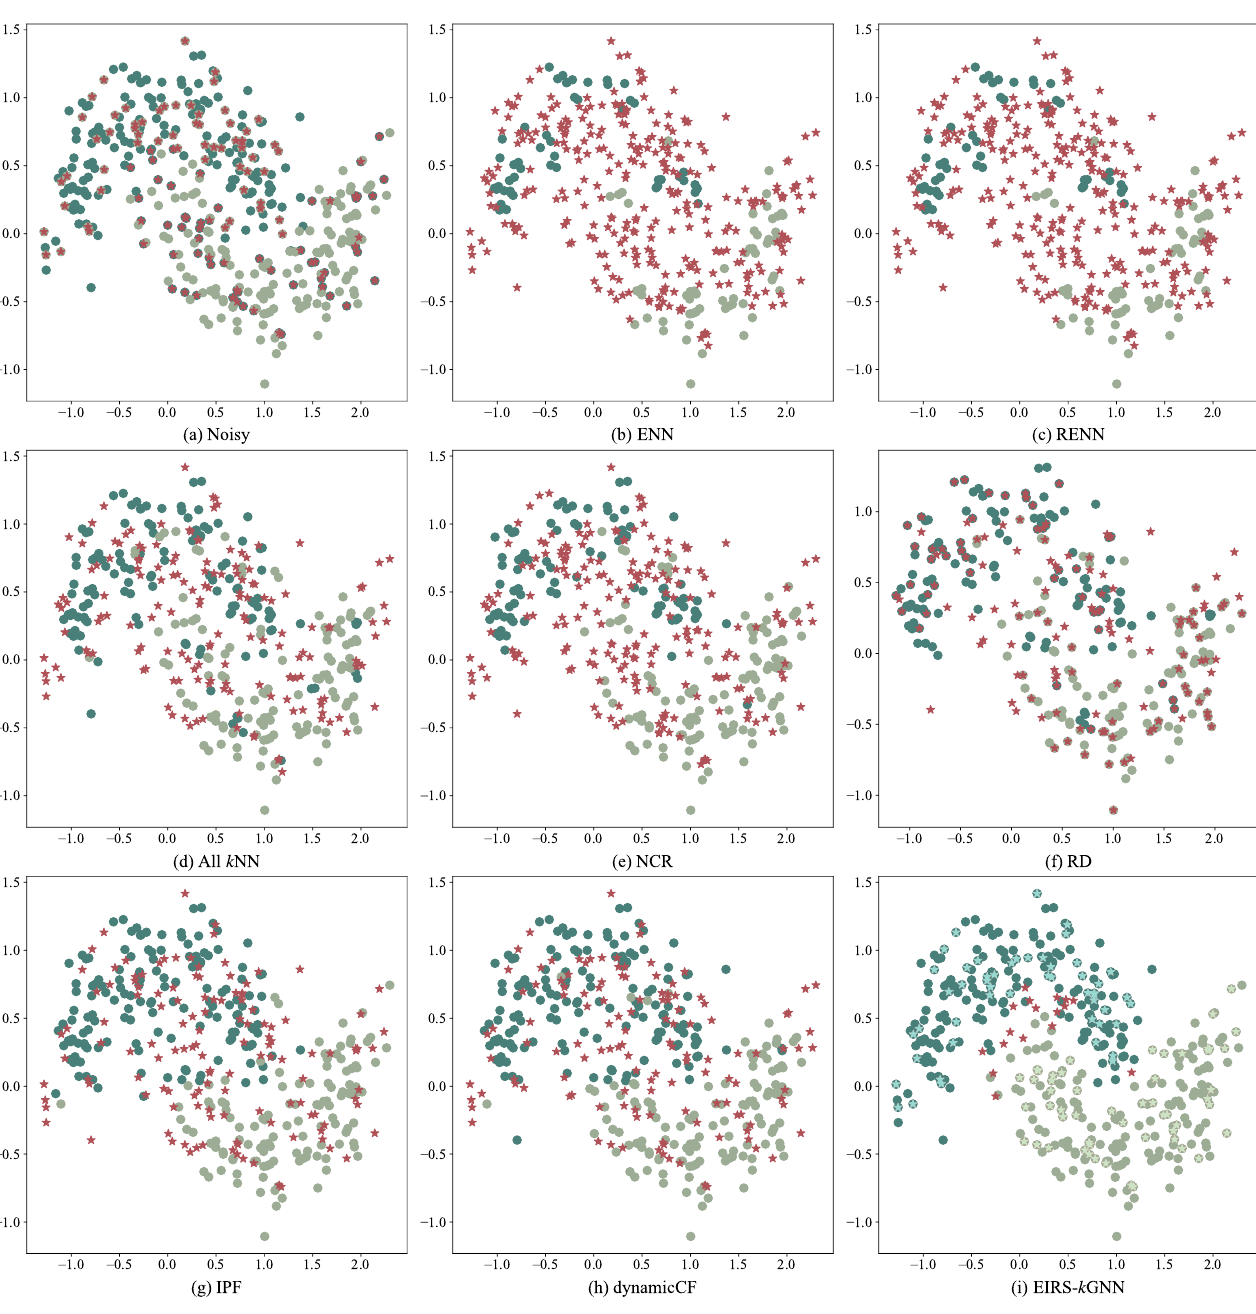
Figure 6. Different performances of various editing methods on the moons data